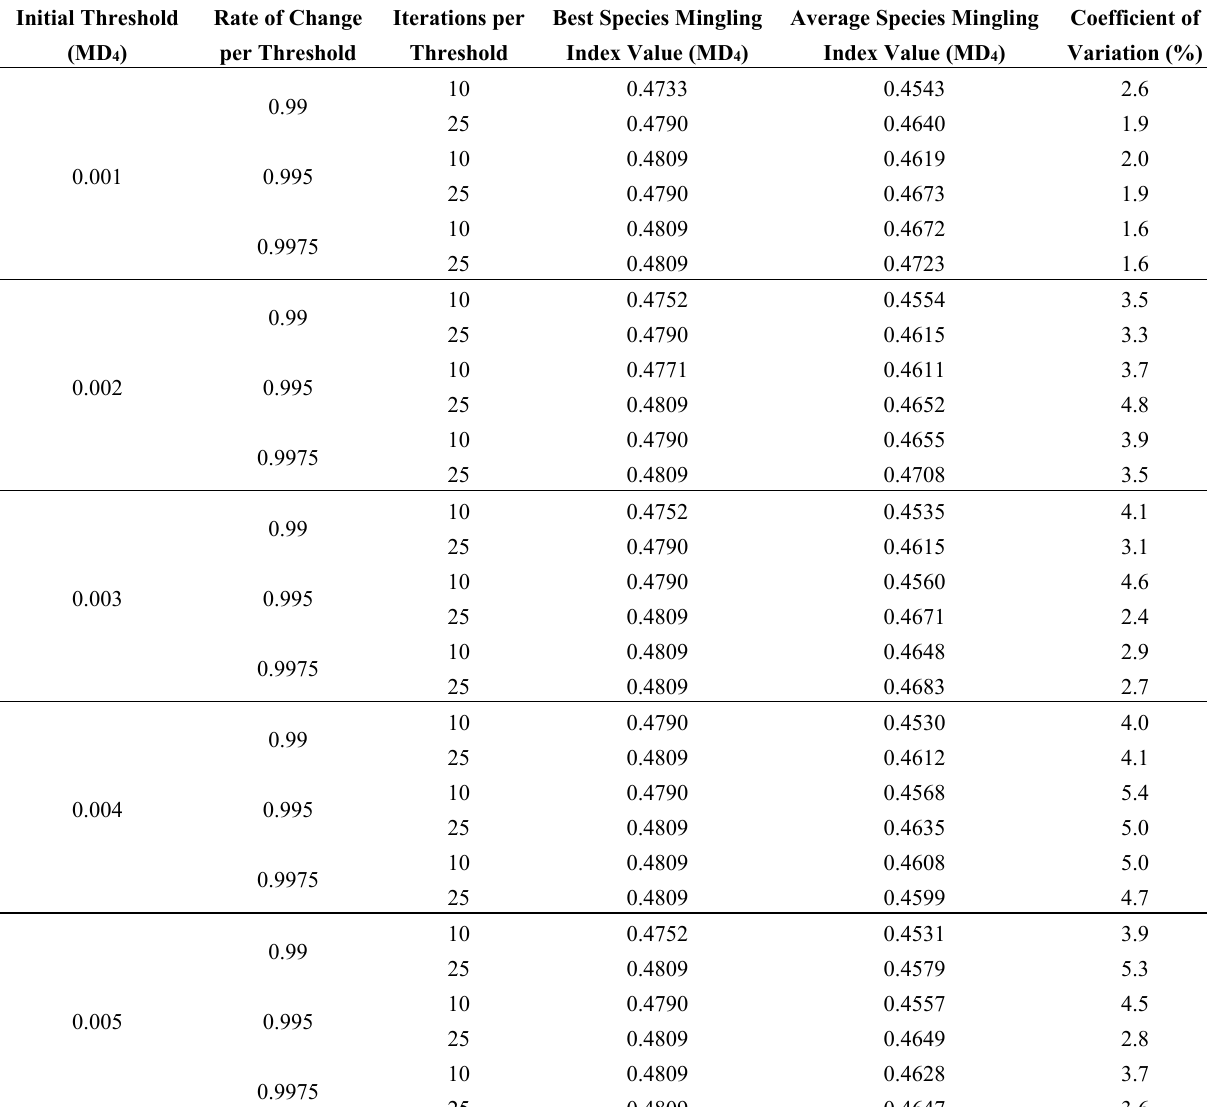
Table 3. Results of the application of threshold accepting to a tree-level harvest schedule of an uneven-aged oak-hickory stand in Georgia (eastern United States), based on maximizing the species mingling index and using non-unique oak tree species as